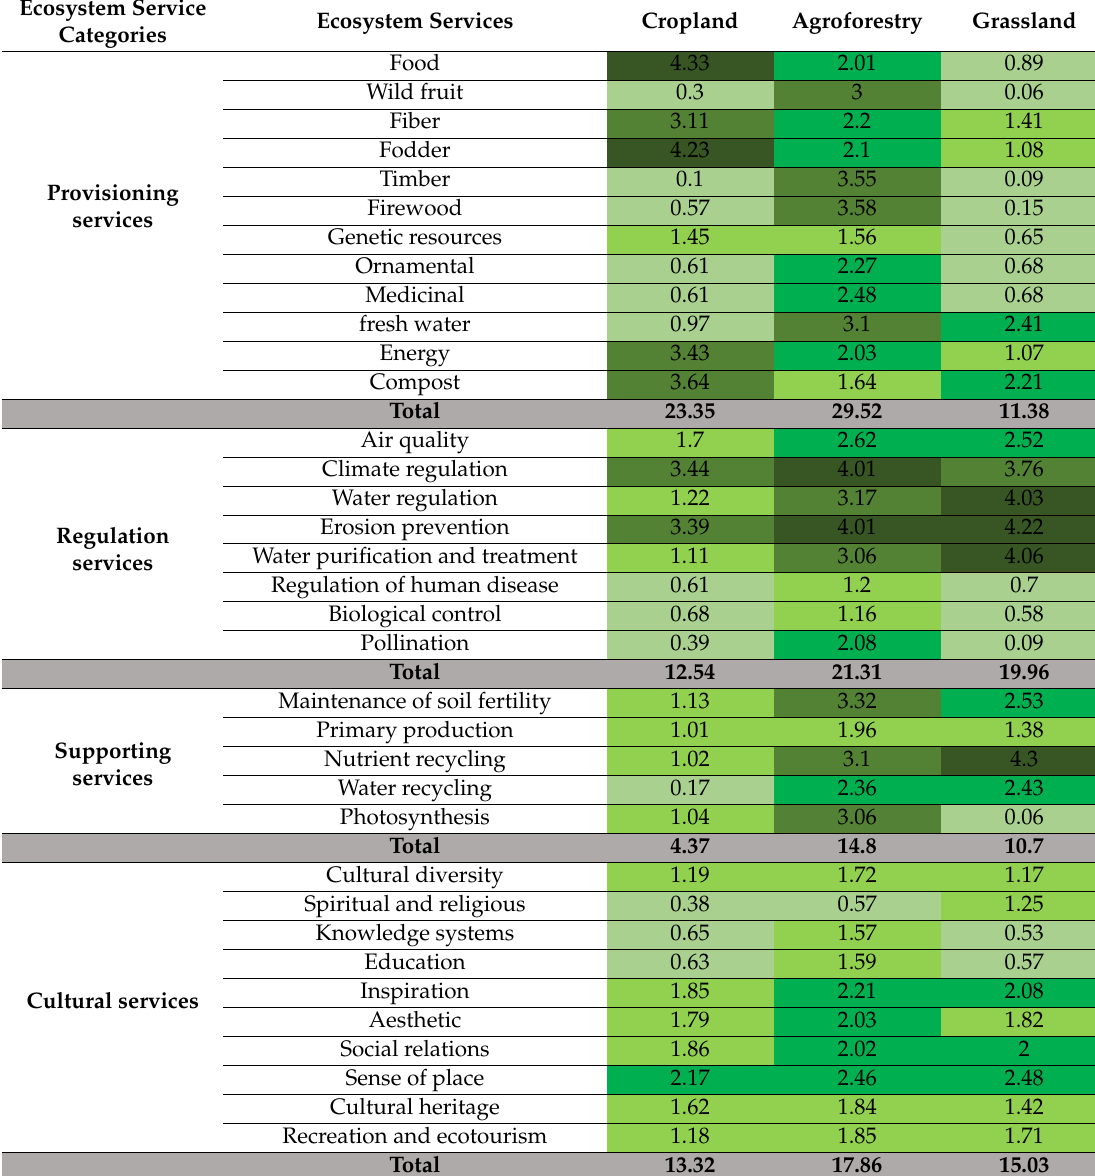
Table 3. Matrix for the assessment of the di ff erent land use types potential to provide selected ecosystem goods and services. The assessment scale reaches from 0.1 to 0.99 = light green = very low relevant potential, 1.0 to 1.99 = yellow green = low relevant potential, 2.0 to 2.99 = green = medium relevant potential, 3.0 to 3.99 = dark green = high relevant potential and 4.0 to 5.00 = very dark green = very high relevant